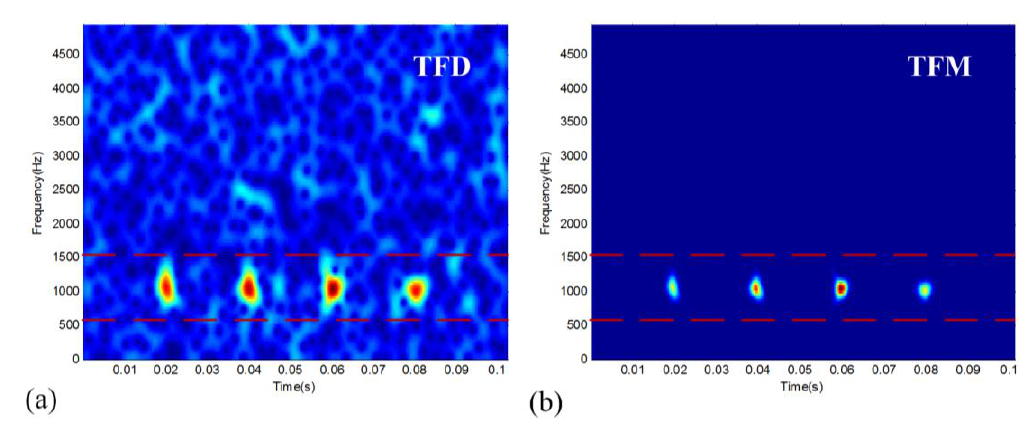
Figure 1. Representation of TFD and TFM for the simulated vibration signal: ( a ) TFD and ( b )